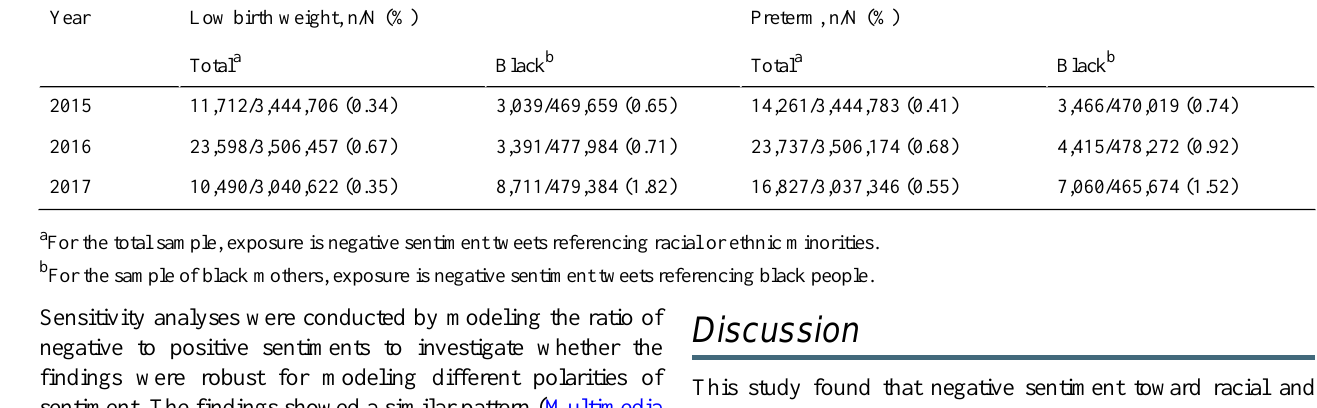
Middle Eastern people and Muslims (minorities)